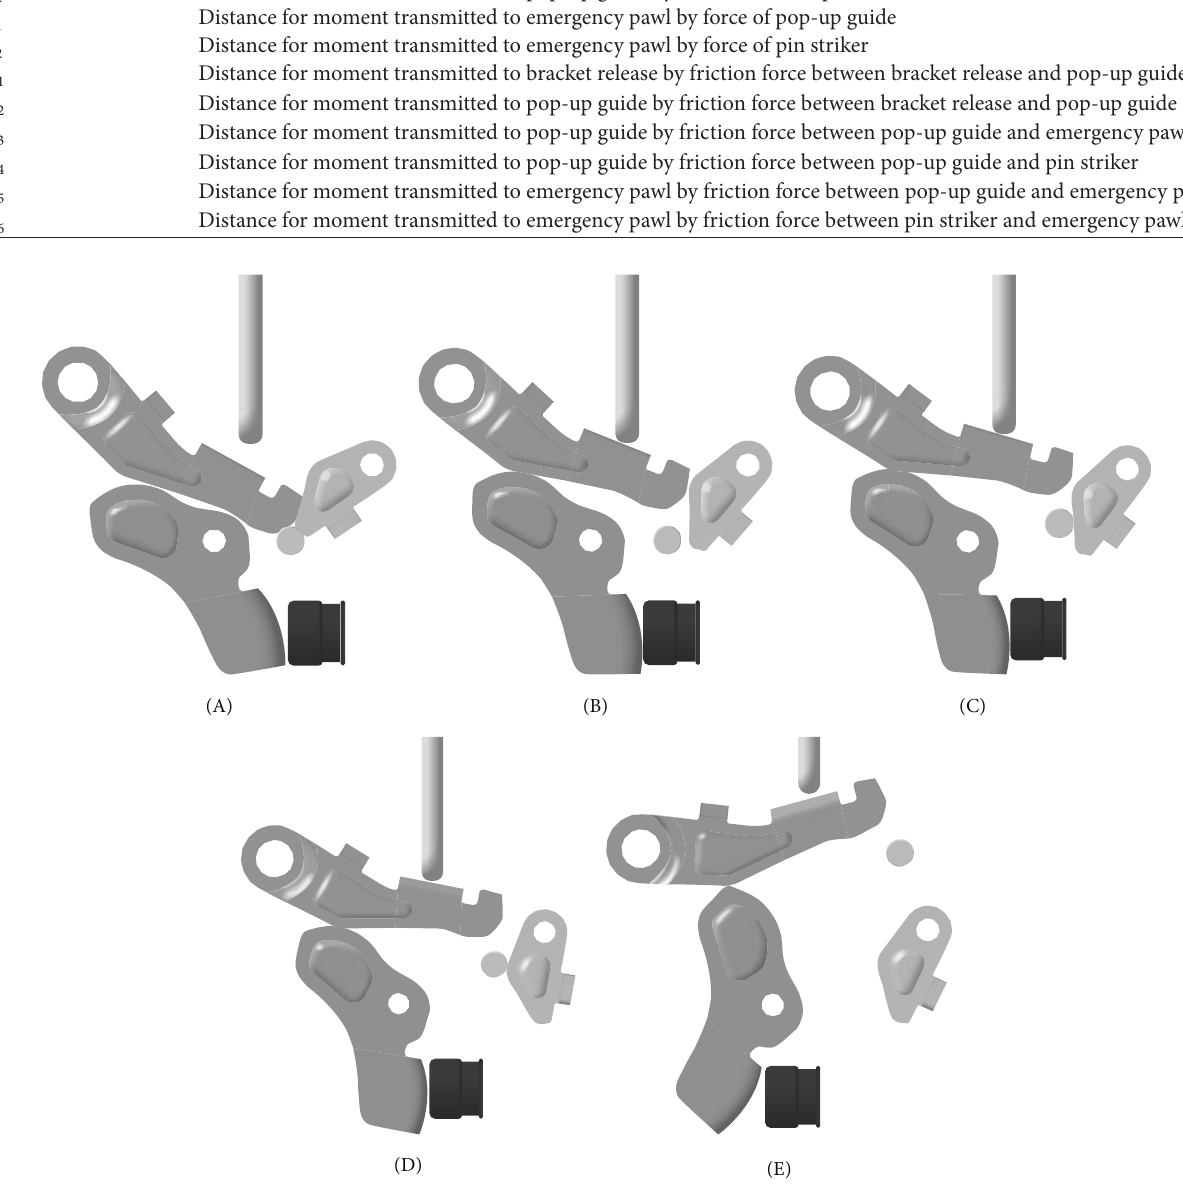
Figure 3: Operation sequence of AHLS for latch